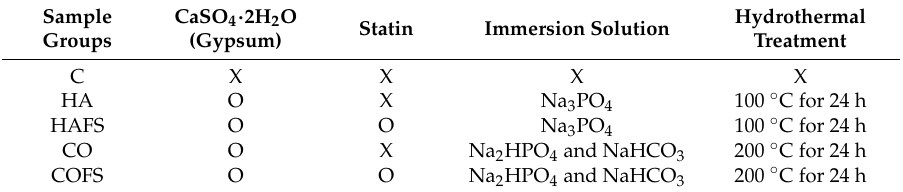
Table 1. Summary of preparation of all of the specimens. C—control; HA—hydroxyapatite low crystalline; HAFS—HA containing fluvastatin; CO—carbonate; COFS—CO containing